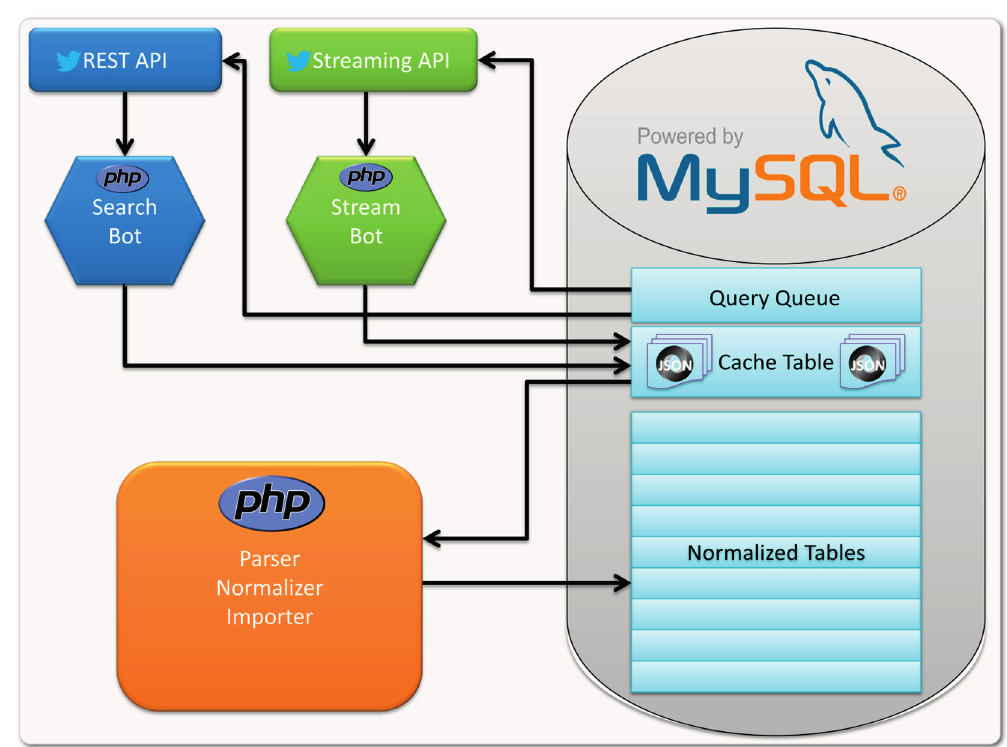
Figure 1. The collecting